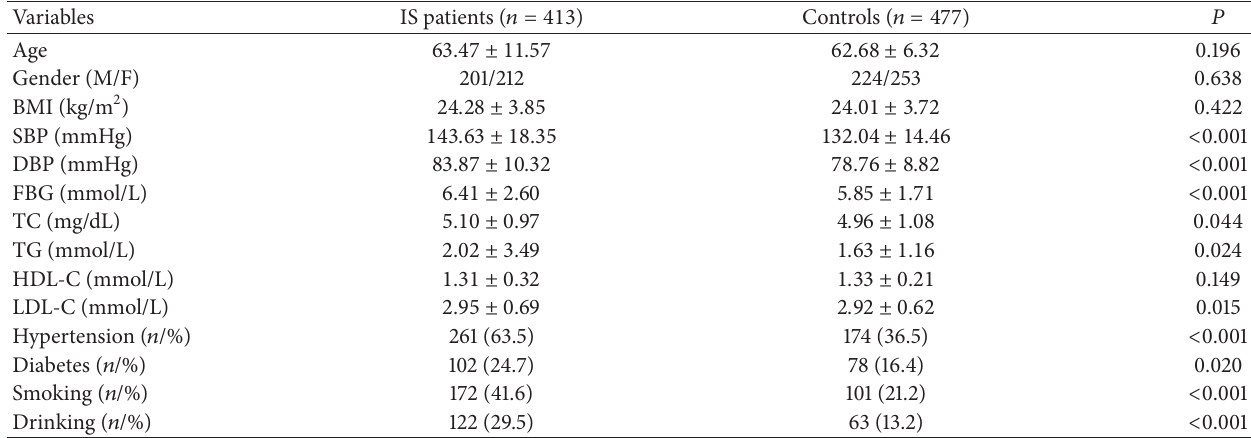
Table 1: Clinical information of IS patients and controls at